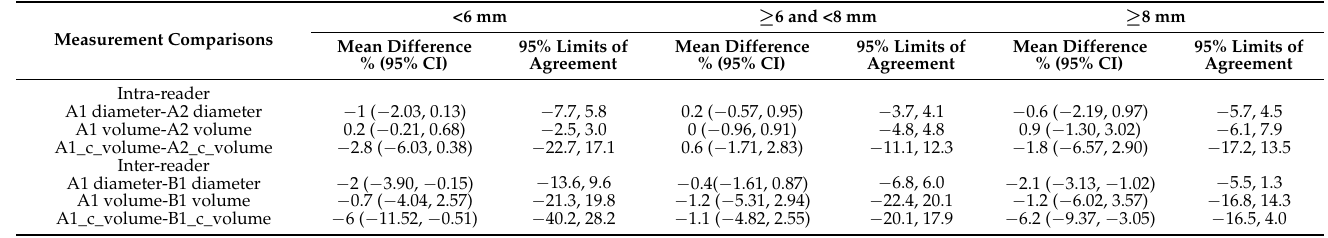
Table 5. Mean differences and limits of agreement of different nodule sizes.